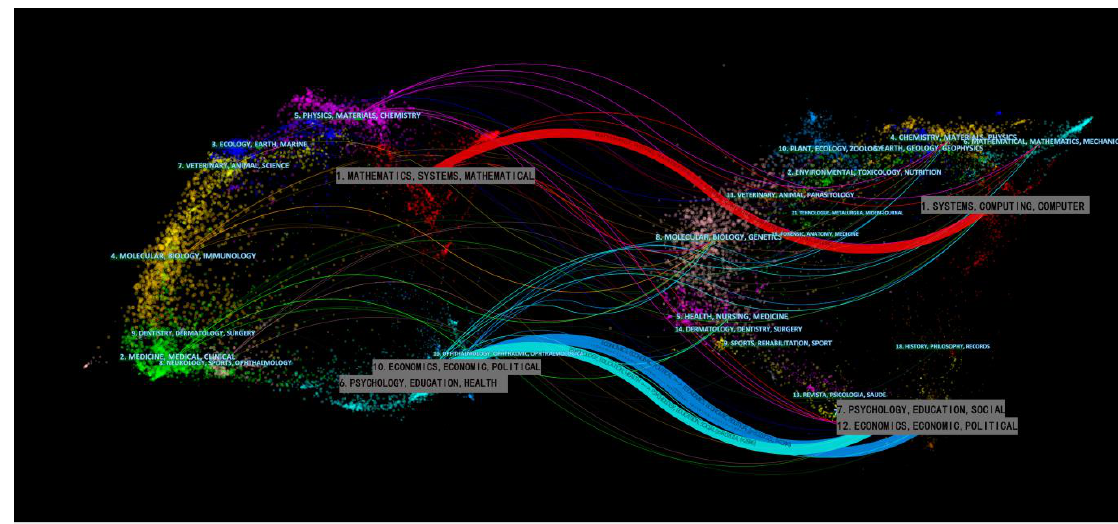
Figure 4. A dual-map overlay of the final document storage. (The color curves represent the reference paths; the most frequently appeared words in the corresponding journals are used to label each area.).